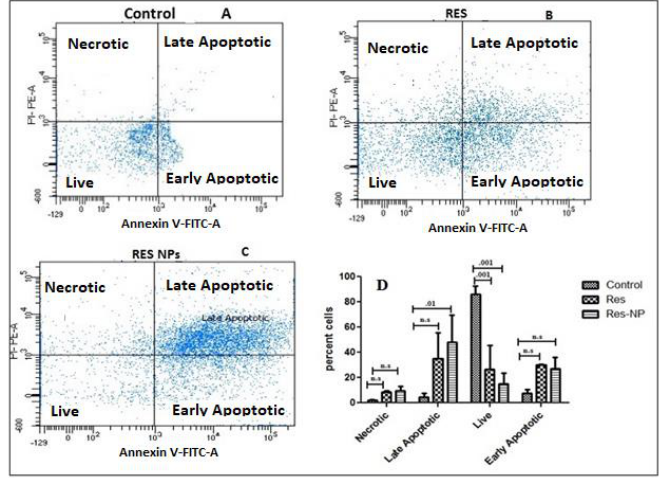
Figure 10. Flow cytometric dot plots of annexin V/PI staining are shown in ( A ) untreated H1299 cells (Control) ( B ) H1299 cells treated with RES ( C ) H1299 cells treated with RES NPs. ( D ): Flow